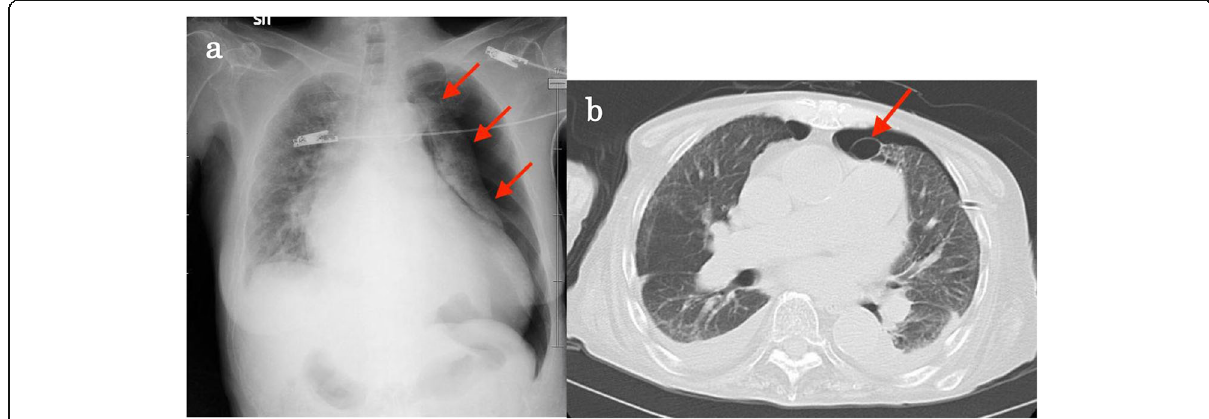
Fig. 1 Preoperative images of the patient. a Chest X-ray shows the collapsed lung (red arrows). The left pneumothorax is severe. b Computed tomography shows a bulla of the left upper lobe behind the sternum (red arrow). The bulla was suspected as the cause of the